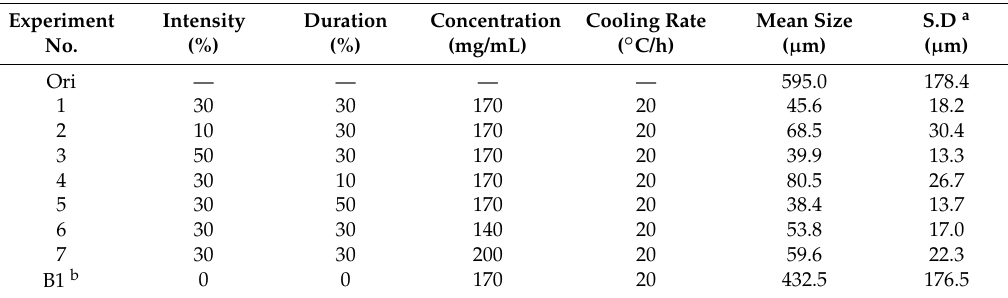
Table 2. Particle size reduction of salicylamide.